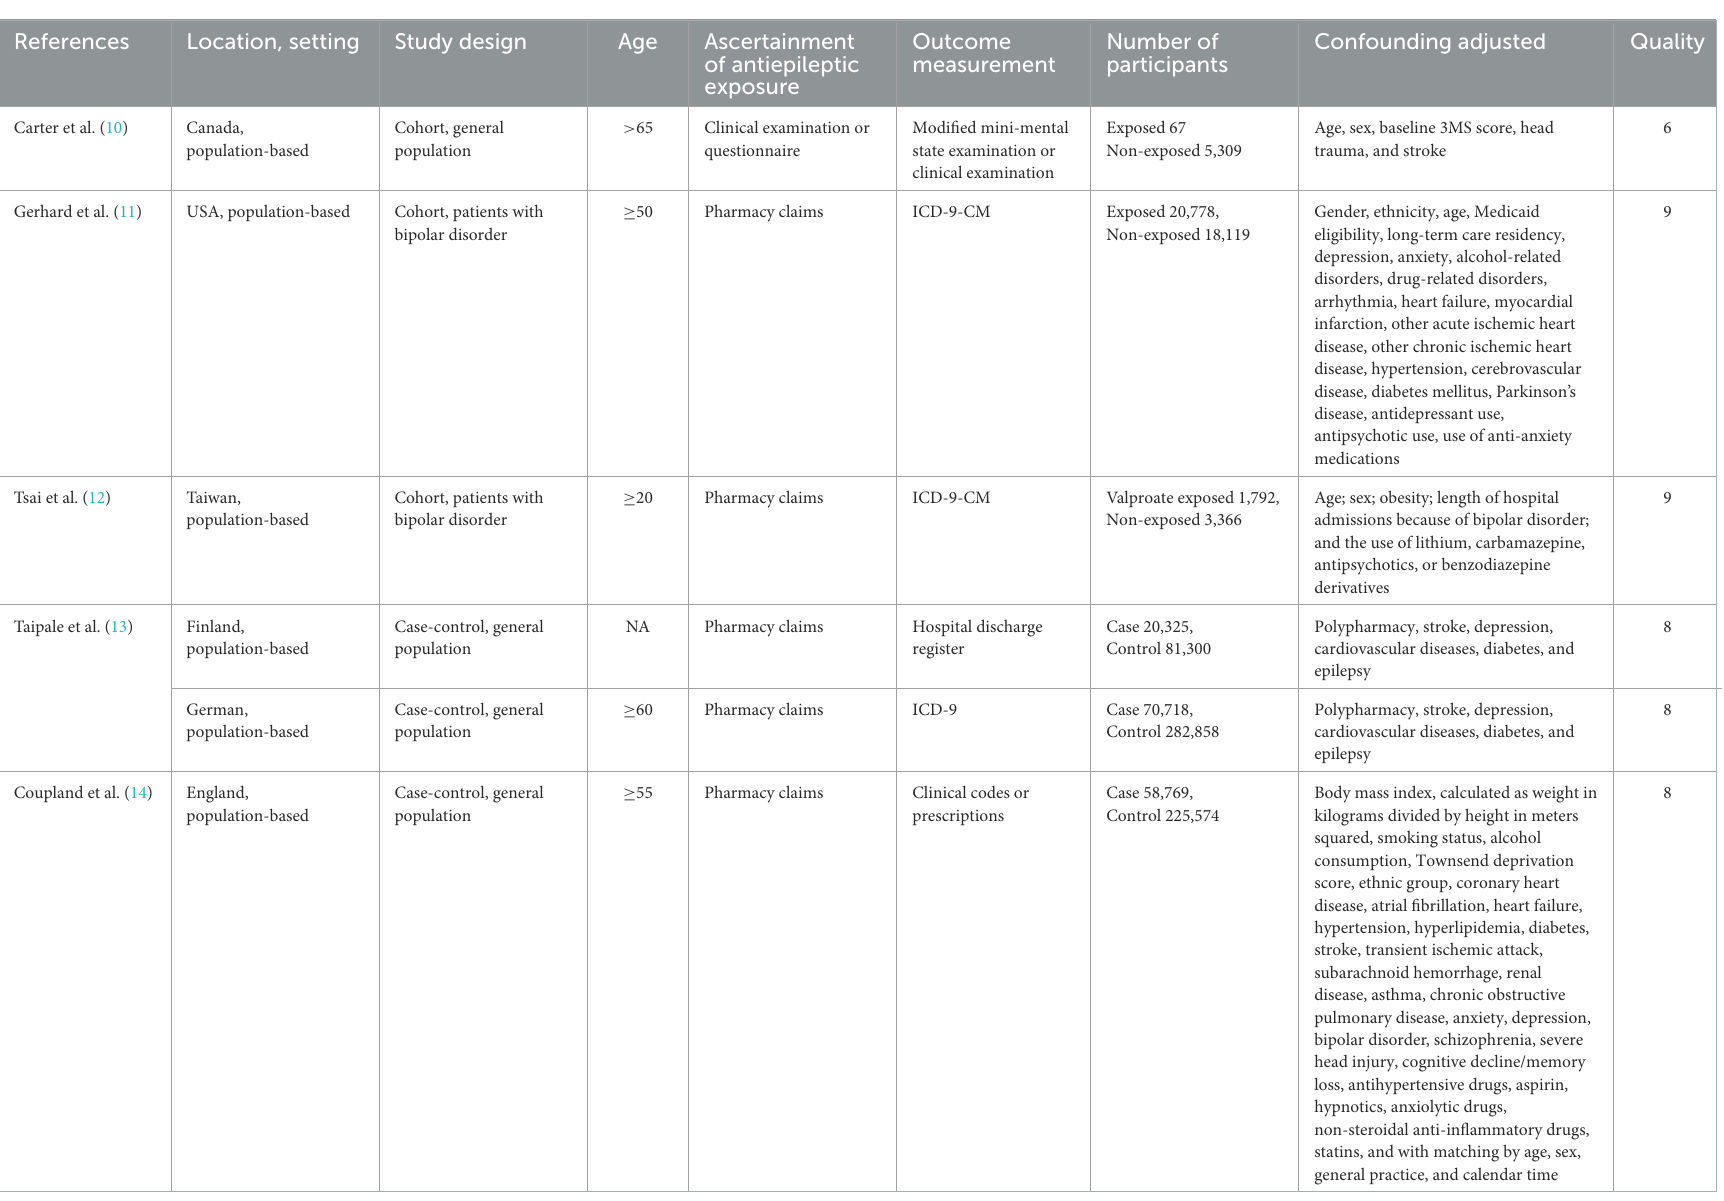
TABLE 1 Characteristics of the included